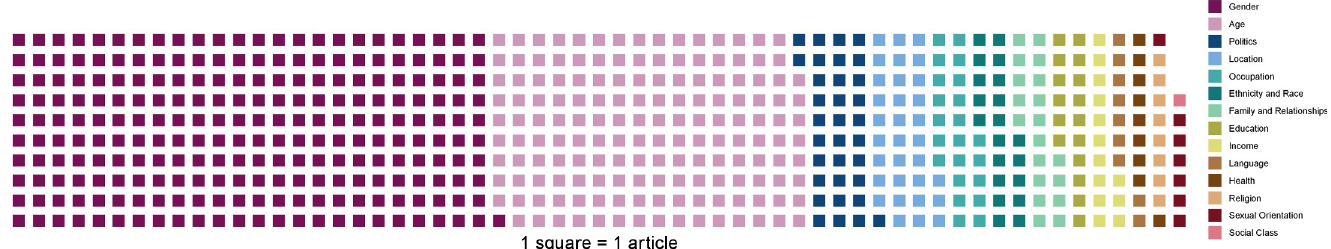
Fig 2. Waffle chart highlighting the proportion of demographic attributes comprising our dataset.